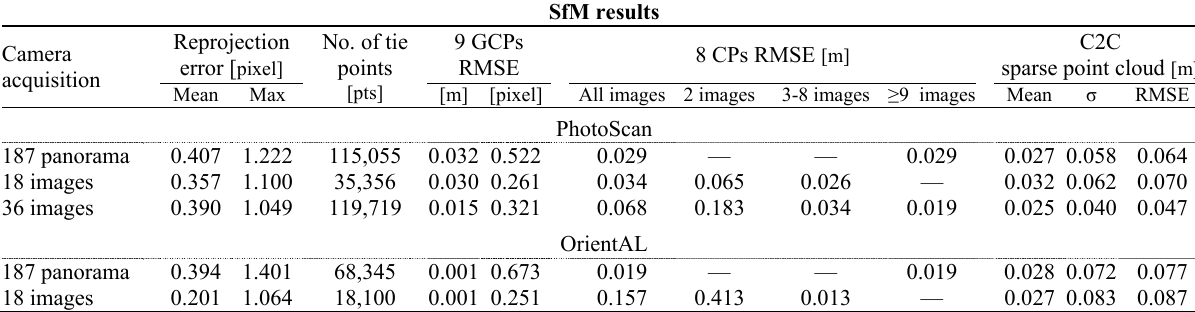
Table 1. Dataset characteristics and image processing results for single images acquisition vs. panorama acquisition using PS and OA.